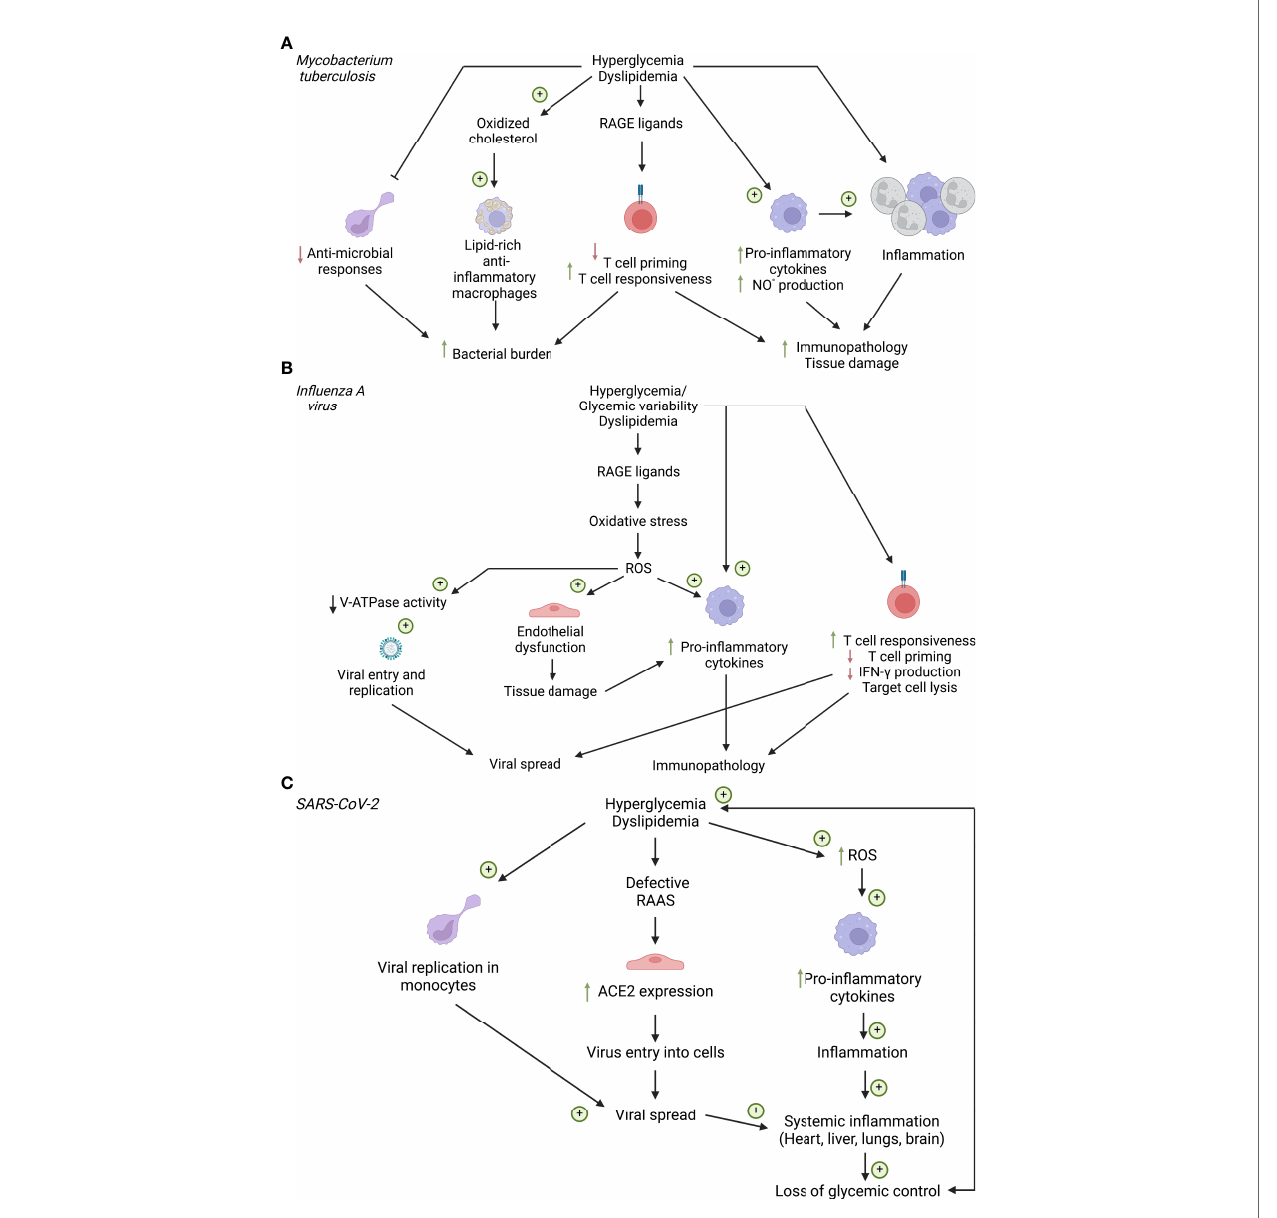
FIGURE 2 | Cellular factors in fl uencing respiratory infections in diabetes. (A) Cellular factors in fl uencing Mycobacterium tuberculosis infection. (B) Cellular factors in fl uencing in fl uenza A virus Infection. (C) Cellular factors in fl uencing SARS-CoV-2 infection. ACE2, Angiotensin converting enzyme 2; NO°, nitric oxide; RAAS, renin- angiotensin-aldosterone system; RAGE, Receptor of advanced glycation end products; ROS, reactive oxygen species. Created with